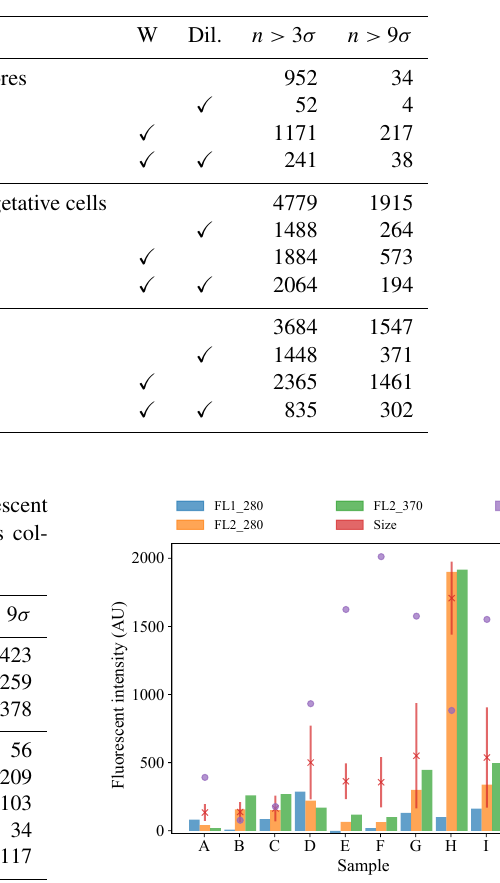
Table 1. The number of particles remaining after a fluorescent threshold of 3 σ or 9 σ was applied for each of the bacterial samples collected in 2008. Each sample was either washed or unwashed and diluted or undiluted. Each sample was either washed or unwashed, and diluted or undiluted as indicated by a check mark in the corresponding column.